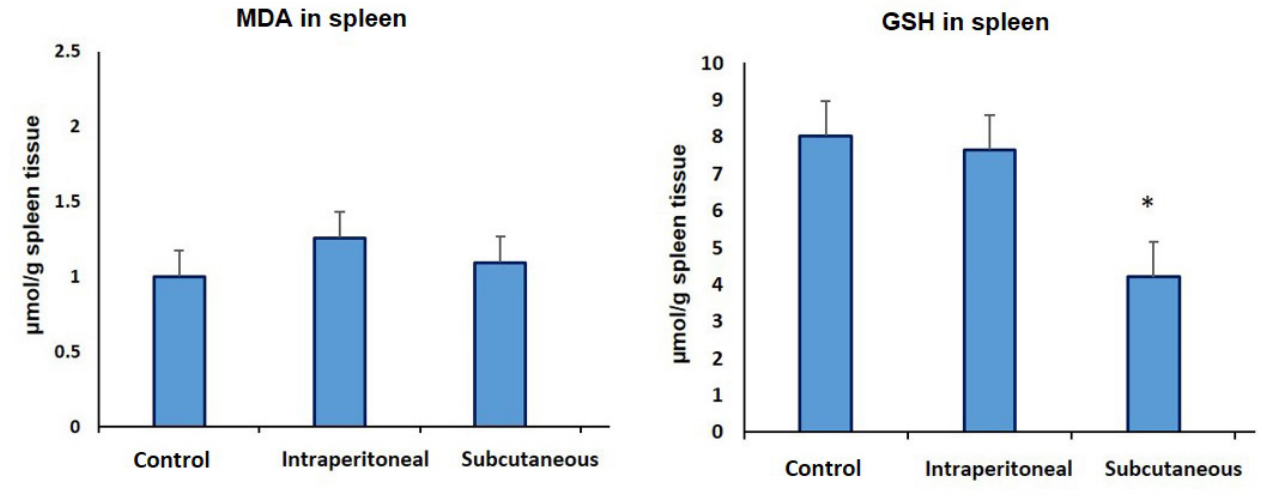
Figure 2. Levels of lipid peroxidation and glutathione in different rat groups, namely, control, intraperitoneal SAV-injected and subcutaneous SAV-injected rats.